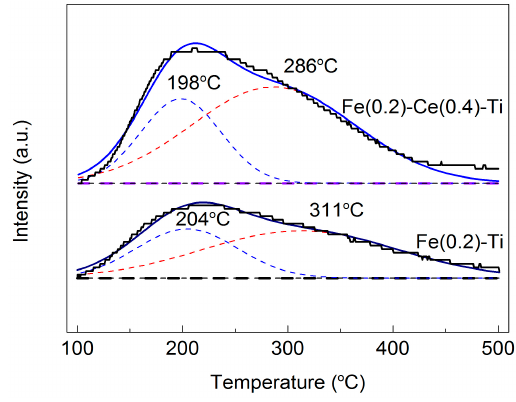
Figure 7. NH 3 -TPD results of Fe(0.2)–Ti and Fe(0.2)–Ce(0.4)–Ti Figure 7. NH 3 ‐ TPD results of Fe(0.2)–Ti and Fe(0.2)–Ce(0.4)–Ti catalysts.